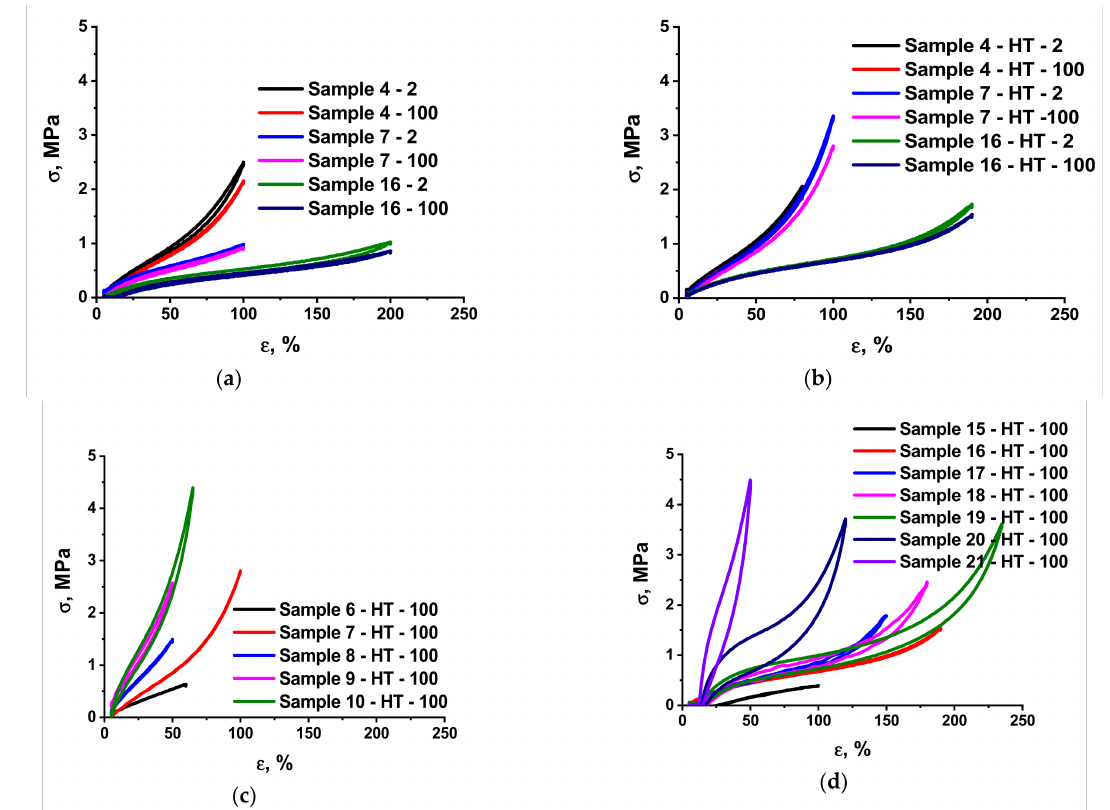
Figure 3. Dynamics of changes in mechanical hysteresis (2nd and 100th cycles) in composites with various compositions before and after HT: ( a ) Corresponds to the composites filled with 16.67 wt.% M2 based on P1 (not containing (Sample 4) or containing (Sample 7) P3 ) and P2 (containing (Sample 14) P3 ) before HT; ( b ) Corresponds to the composites filled with 16.67 wt.% M2 based on P1 (not containing (Sample 4) or containing (Sample 7) P3 ) and P2 (containing (Sample 16) P3 ) after HT; ( c ) Corresponds to the thermally treated composites based on P1 and P3 containing 9.09 to 33.33 wt.% M2 (100th cycles) (Samples 6–10); ( d ) Corresponds to the thermally treated composites based on P2 and P3 , containing 9.09 to 50.00 wt.% of M2 (100th cycles) (Samples